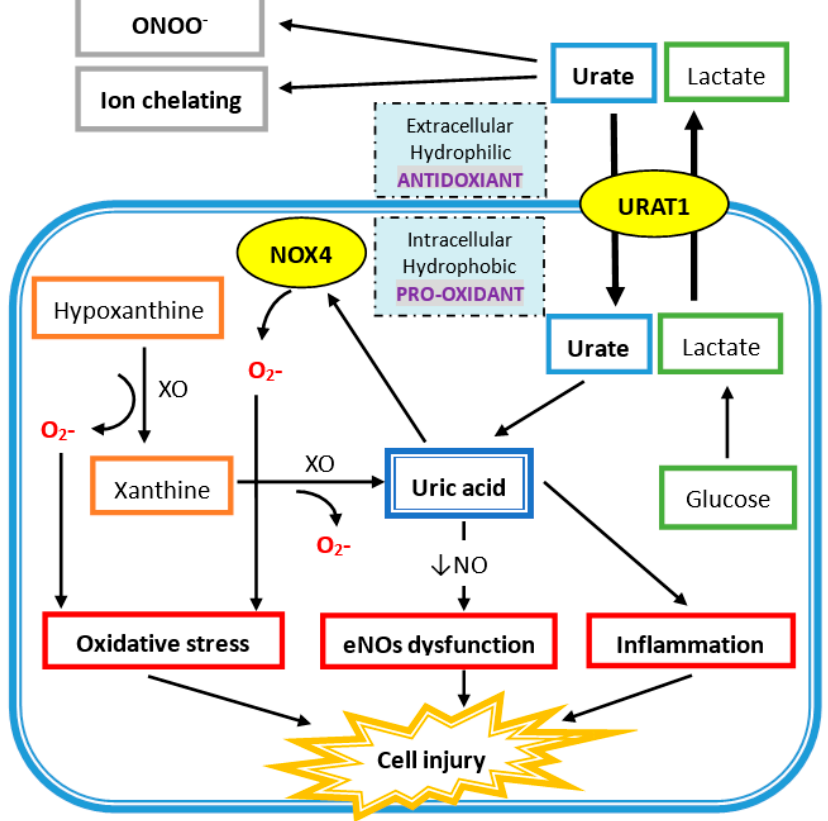
Figure 1. Uric acid (UA) acts as a hydrophobic pro-oxidant within the cell and a hydrophilic antioxidant outside the cell. Urate enters the cell via UA transporter 1 (URAT1) on the cell membrane. UA is produced from xanthine via xanthine oxidase (XO) in the cell and also generates superoxide ions (O 2 − ), which also promotes oxidative stress by superoxide free radicals produced via NADPH oxidase (NOX4). UA intracellularly induces endothelial nitric oxide synthase (eNOs) with a decrease in nitric oxide (NO) generation. It also directly increases inflammation, which leads to cell